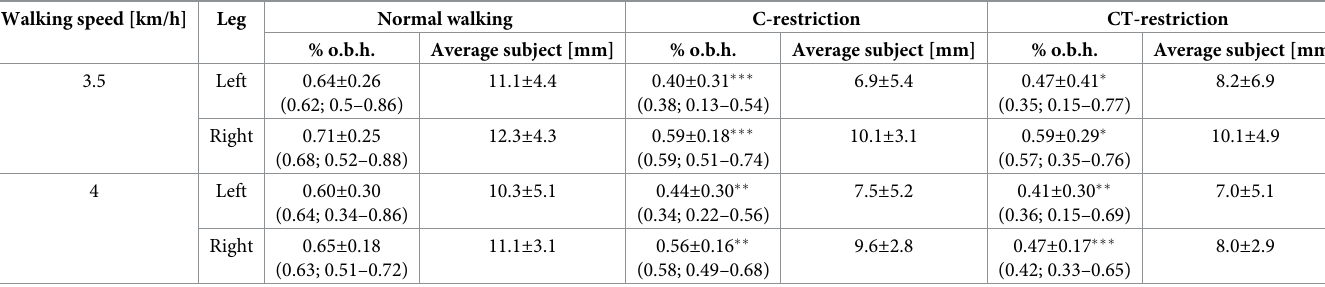
Table 2. MTC central tendency (median) between subjects.